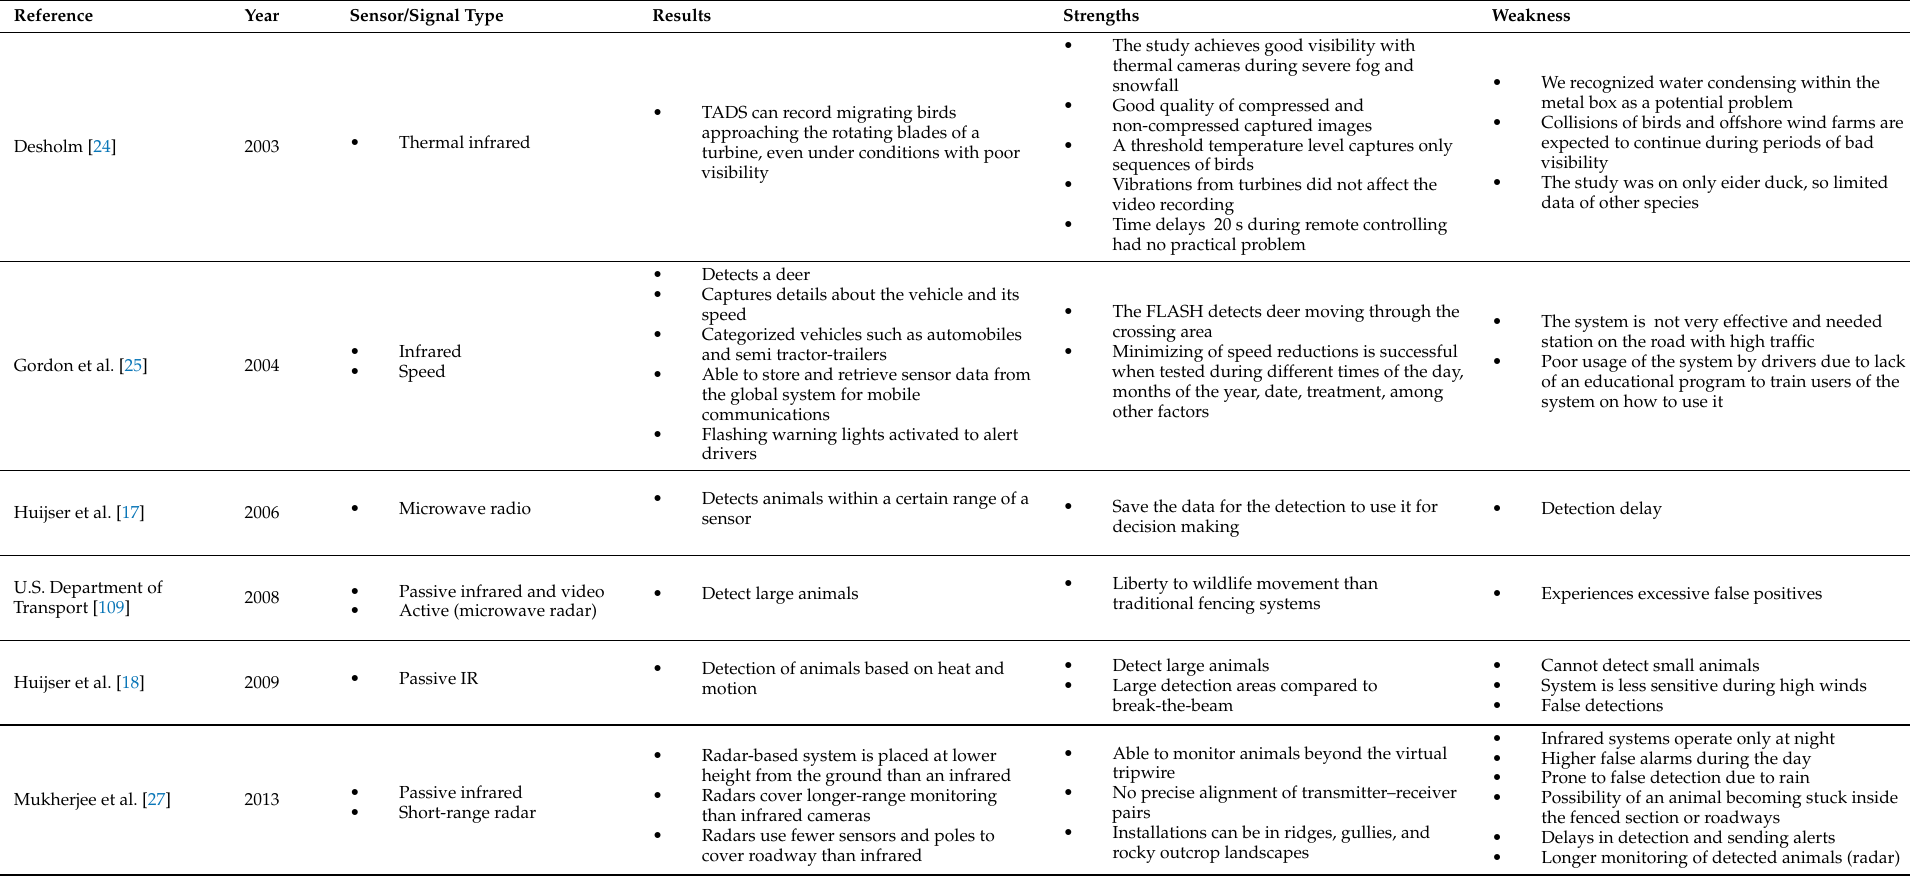
Table 5. A comparison of areas cover systems in terms of their sensor types, performances, strengths, and